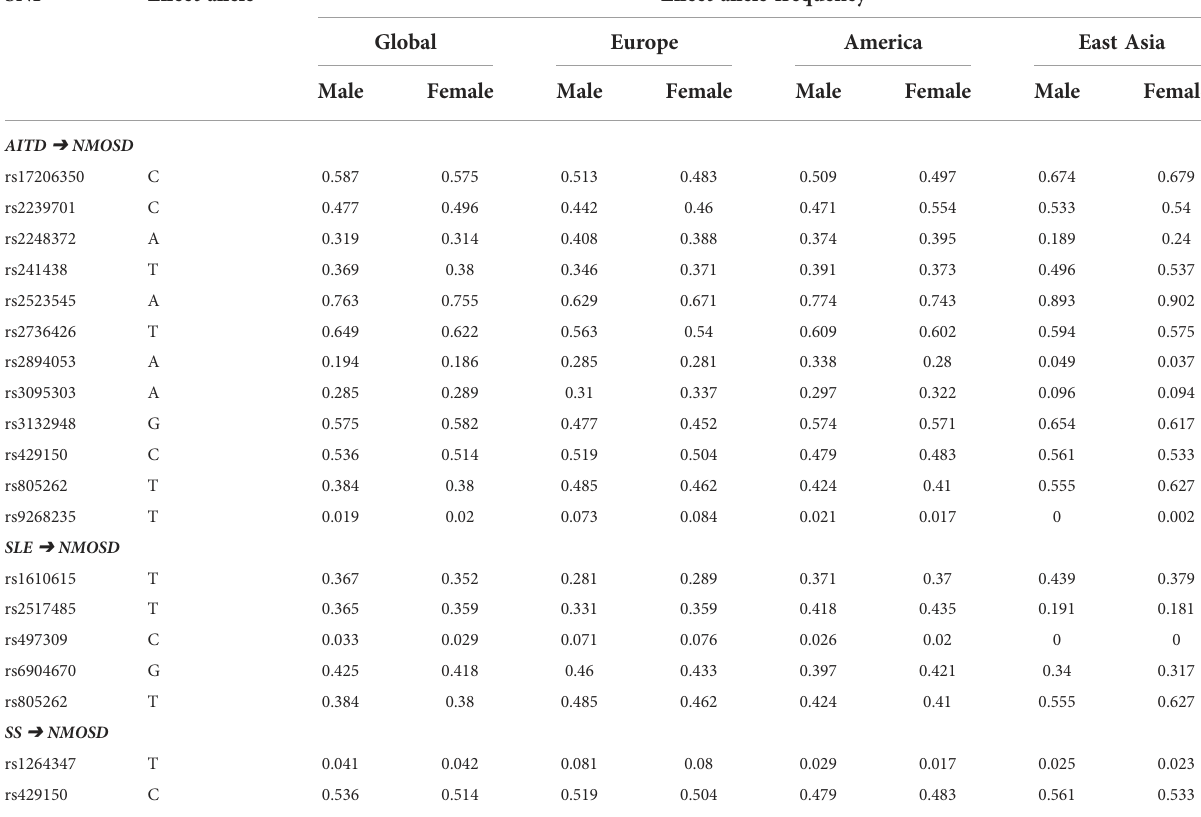
TABLE 3 Frequencies of causal SNPs of NMOSD on the exposure of autoimmune diseases based on genders. SNP Effect allele Effect allele